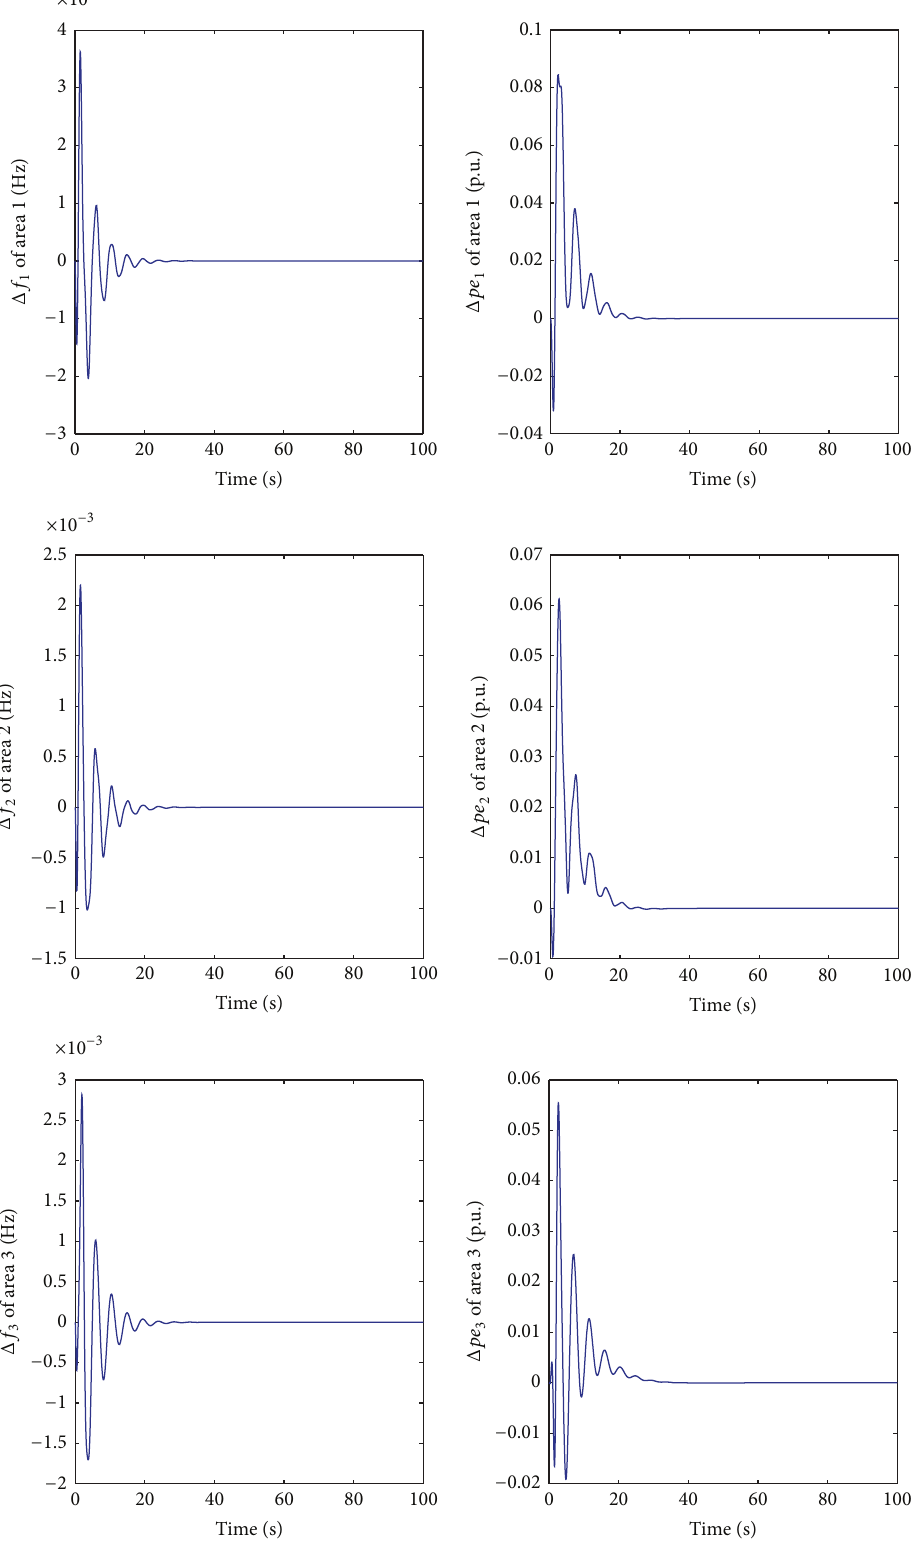
Figure 8: Step responses of the expanded system when 𝐸 2,3 varies from 1 to